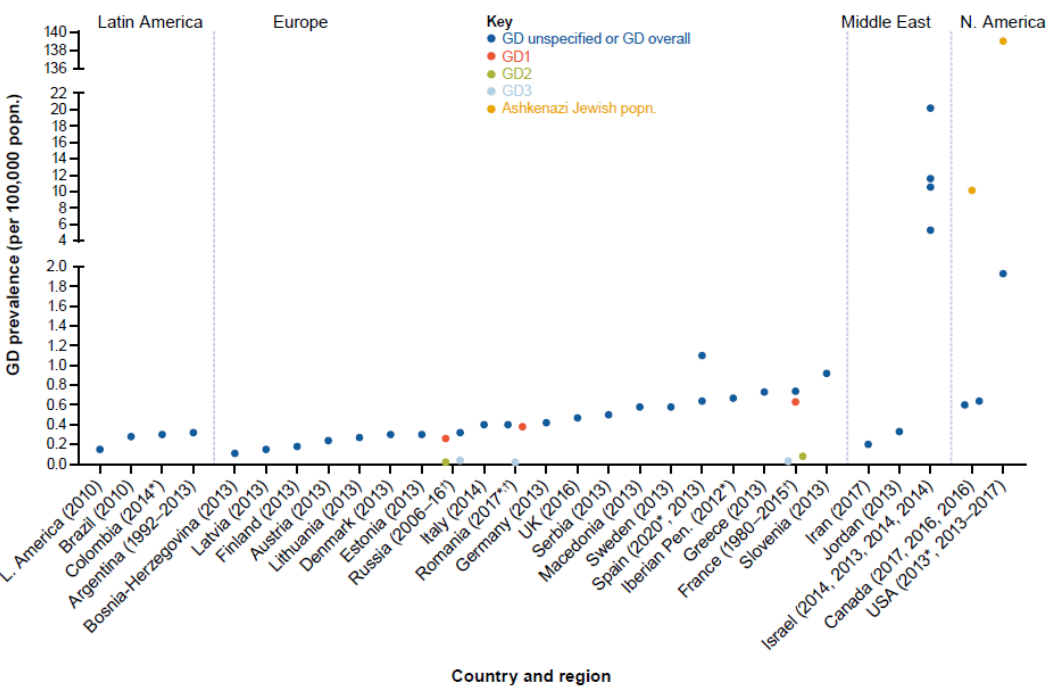
Figure 5. Summary GD prevalence estimates by country and region. GD unspecified refers to absence of any mention of whether study targeted GD overall or a given type. * Year of publication. † Study reported prevalence estimates for more than one GD type and GD overall.